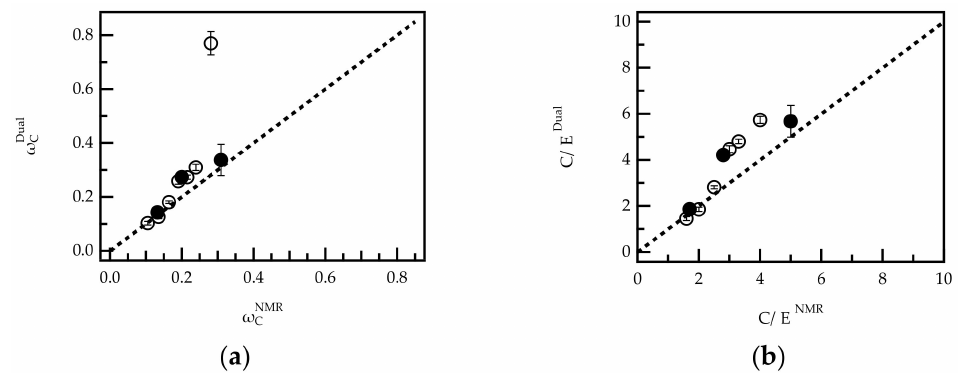
Figure 4. Comparison of copolymer composition in G-PCEs (O) and FRC-PCEs (l) calculated from 1 H-NMR data and dual concentration detection SEC expressed as weight fraction of comonomer C ( ω C ) ( a ) and C/E ratio ( b ). The results for sample G-PCE-5.0 are excluded from graph ( b